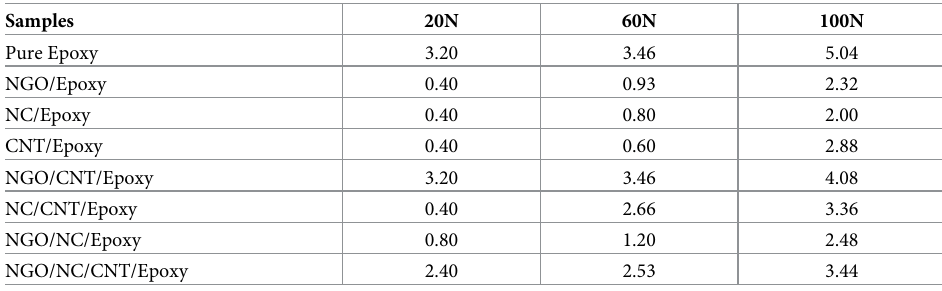
Table 3. Variation of wear rate ( × 10 − 5 mm 3 /N.m) at different loads. Samples 20N 60N 100N Pure